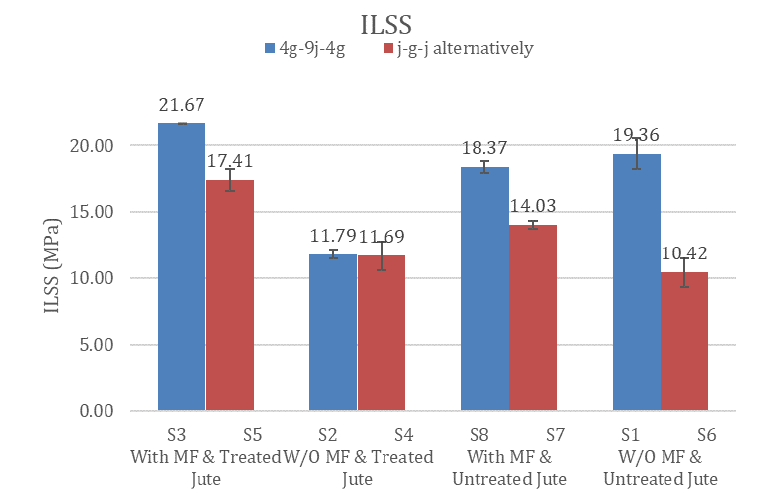
Figure 14: Inter laminar shear strength (ILSS) of hybrid composite panels